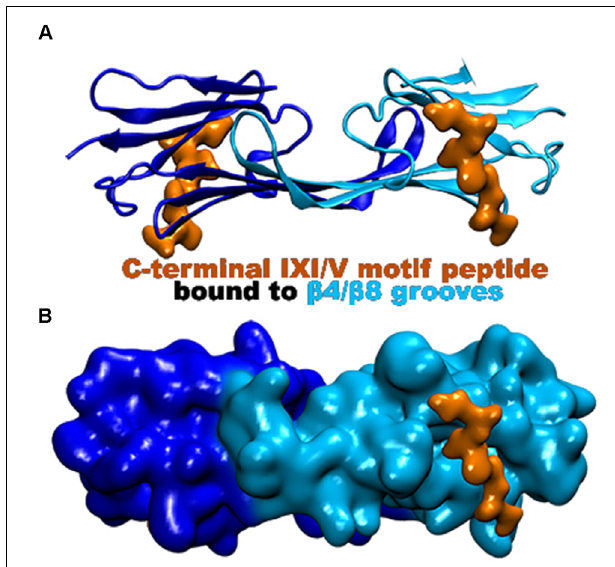
FIGURE 5 | Hsp27 crystal structure (PDB 4MJH) co-crystallized with peptide mimic of the IXI/V motif. The peptide (colored in orange) was found bound to the β 4/ β 8 groove as indicated. (A) Ribbon representation of the dimer illustrating the location of the two bound peptides. (B) Surface representation of the dimer that better illustrates the β 4/ β 8 groove with the bound